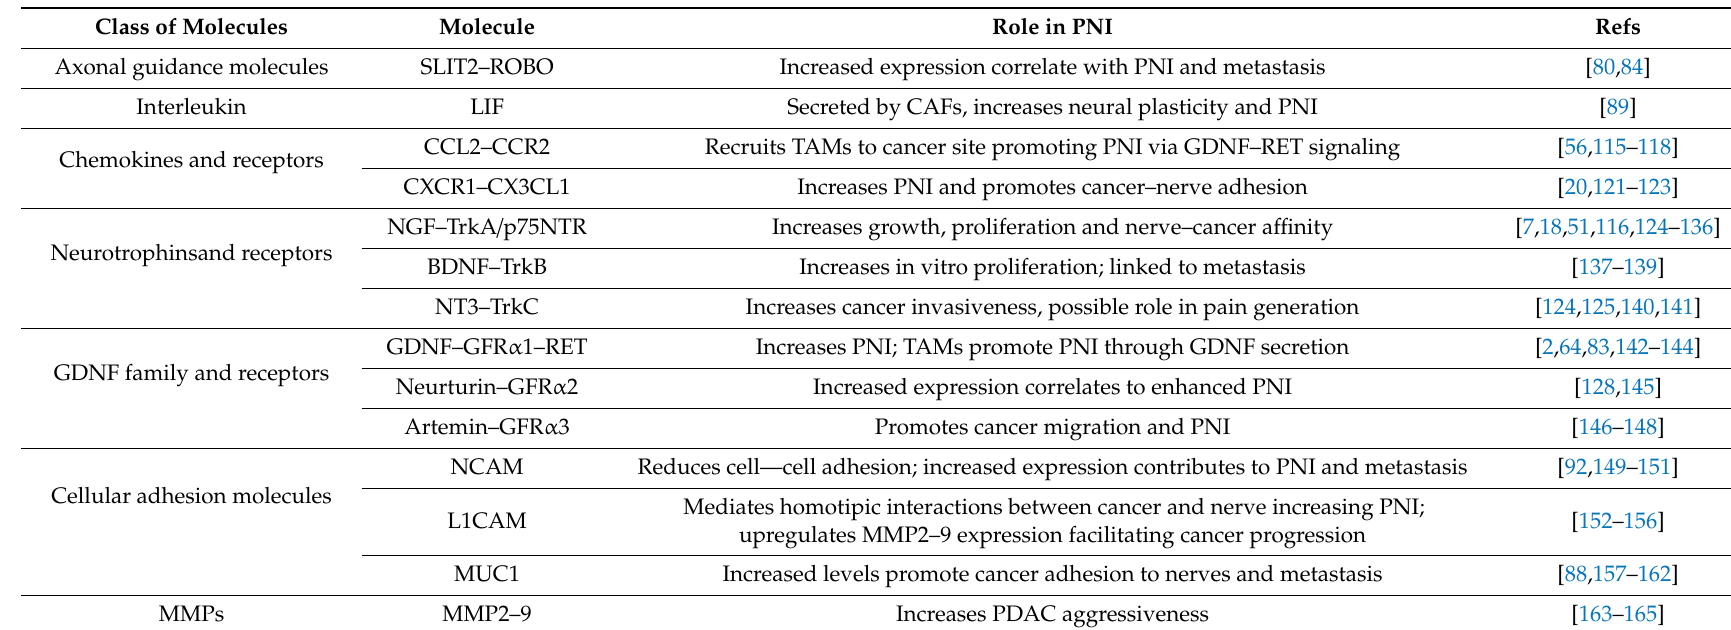
Table 1. Molecules involved in